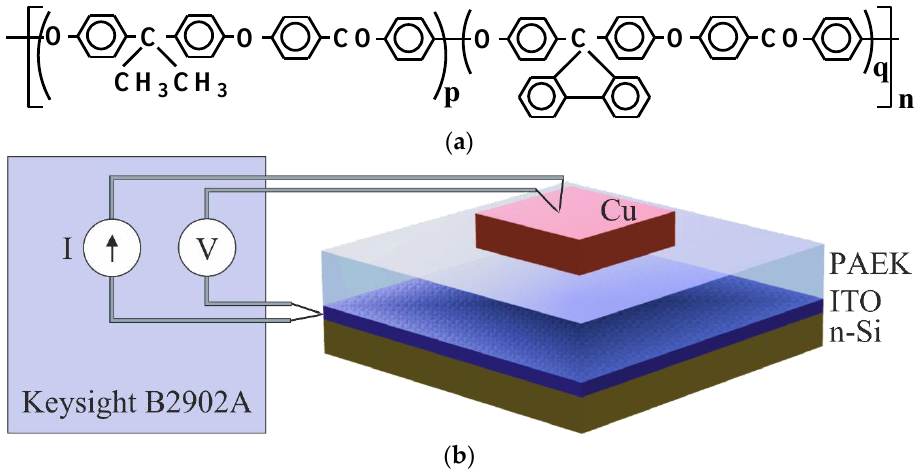
Figure 1. ( a ) Structural formula of co-PAEK, where p/q = 0.90/0.10; ( b ) block diagram of measure- ments and schematic structure of the Si/ITO/co-PAEK/Cu sample.